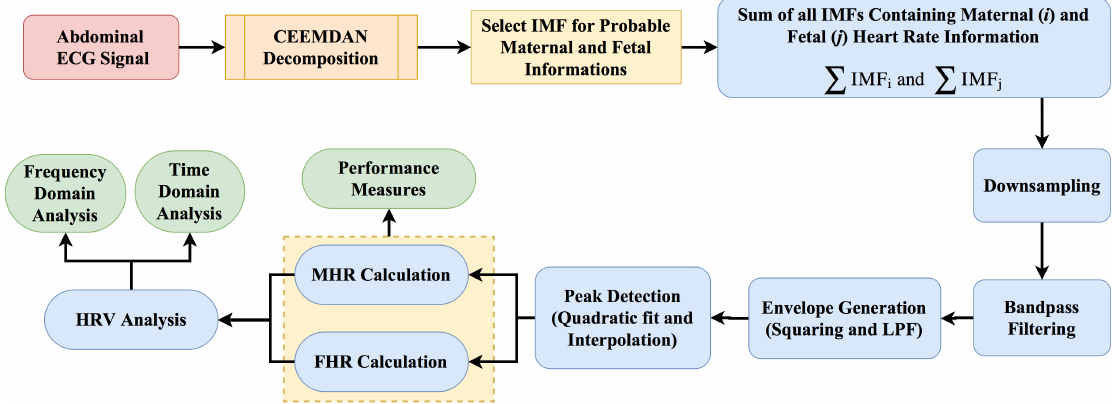
Figure 6. Flowchart of the proposed methodology. HRV, Heart Rate Variability; LPF, Low Pass